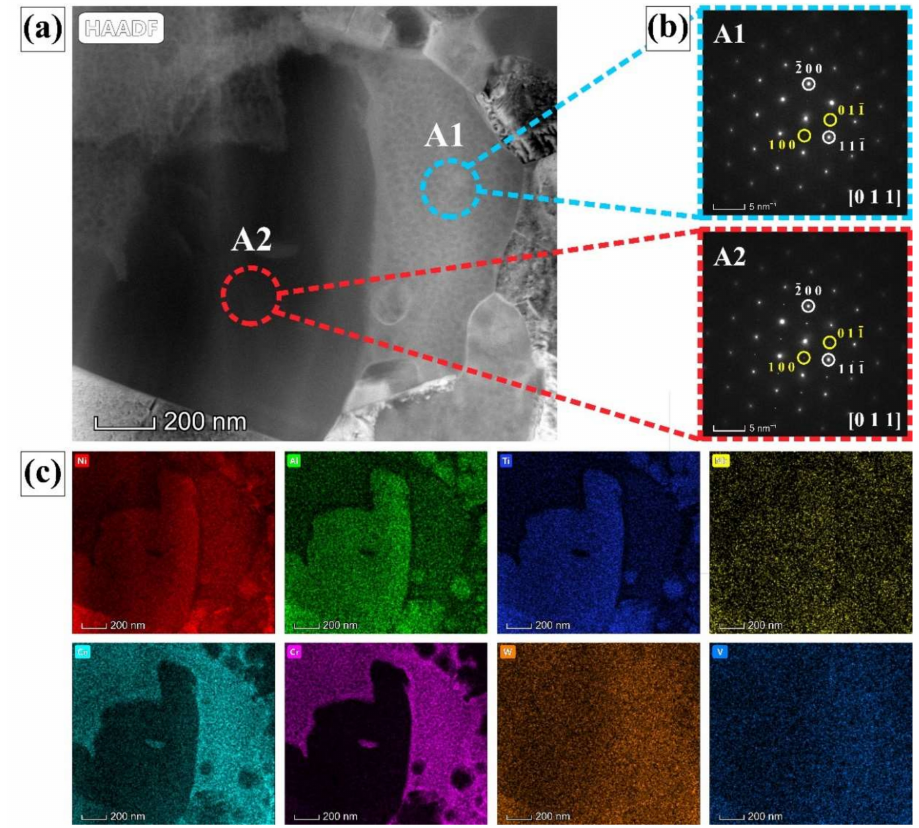
Figure 11. ( a ) HAADF of the dislocation-free DRX grain; ( b ) SAED in [011] zone axis corresponding to the γ matrix (A1) and γ ’ precipitate (A2); ( c ) EDS maps of the dislocation-free DRX grain.